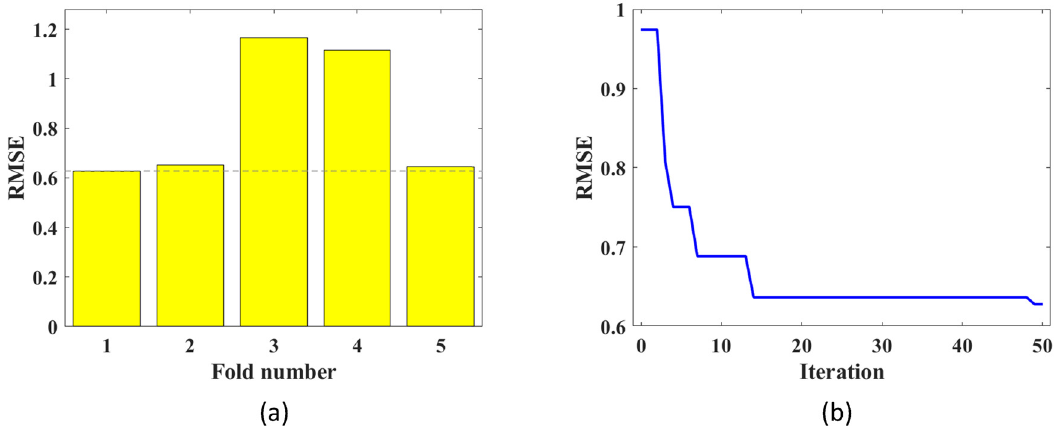
Figure 14: The CV results of displacement ductility coe ffi cient prediction and the optimal fold iterative process. ( a ) 5 - fold CV results. ( b ) The iterative process of optimal fold.